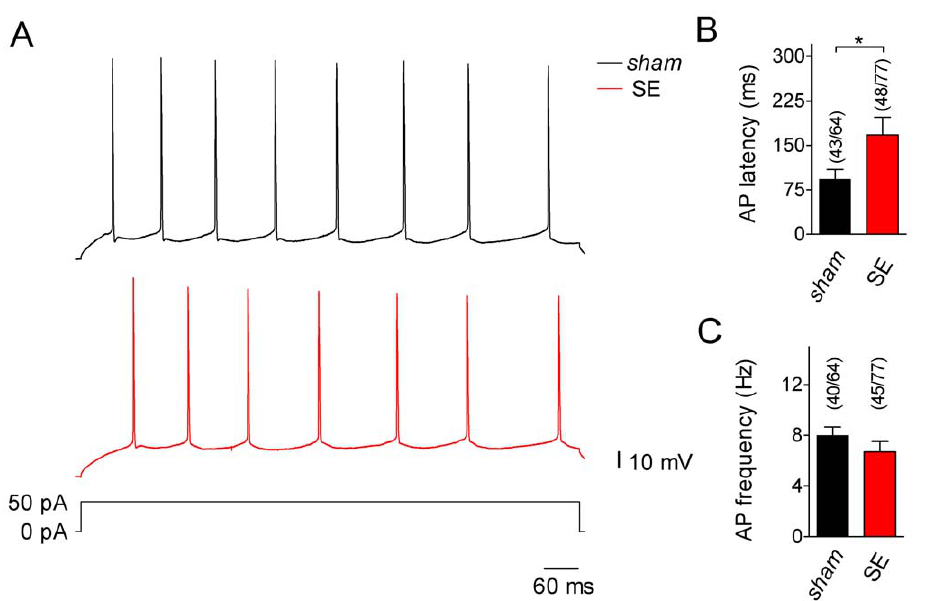
Figure 3. Excitability and discharge behavior of CA1 pyramidal cells. A . Current-clamp recordings (test pulse of + 50 pA for 900 ms as indicated) from a sham (top, black trace) and an SE cell (bottom, red trace). Both cells show regular firing with no sign of burst behavior. Note, however, that in the SE cell it took longer than in the sham cell for the first action potential (AP) to appear. B . Time until the first AP appears (AP latency) in response to a + 50 pA current injection for sham (black bar) and SE cells (red bar); fraction of cells in which firing threshold was reached with + 50 pA is indicated (* p , 0.05). C . AP frequency for sham (black bar) and SE cells (red bar); fraction of cells which fired repetitive APs at + 50 pA is